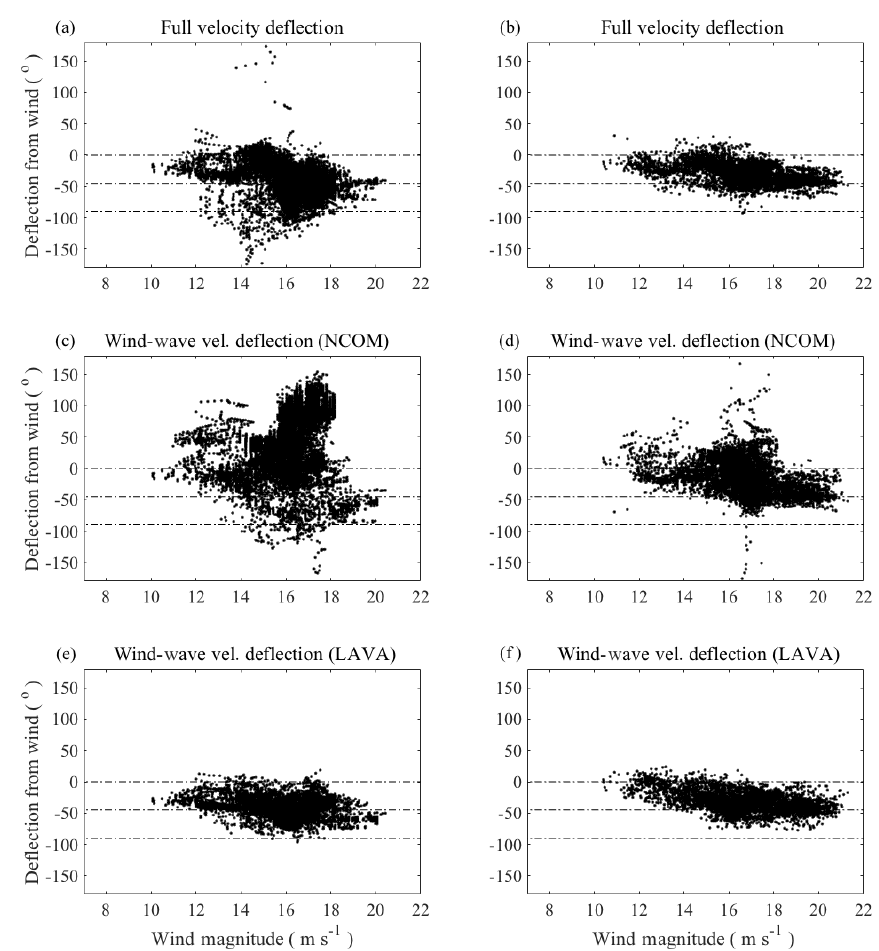
Figure 11. Scatter plots of deflection angles of drogued (a, c, e) and undrogued (b, d, f) drifter velocities before (a, b) and after (c, d, e, f) sub- tracting estimates for the regional circulation during the high wind periods analyzed. Panels (c) and (d) are created using the NCOM velocity fields during the high wind events (Fig. 9), while panels (e) and (f) use the LAVA-derived estimates observed before each high wind event (Figs. 7 and 8). Data points that do not have both individual drifter velocity measurements and coinciding data in the LAVA-derived Eulerian velocity fields of the pre-existing circulation during the high wind event are not included in any panel. Deflection angles are plotted against the U 10 wind magnitude from the UWIN-CM model at the nearest point to the drifter locations in the